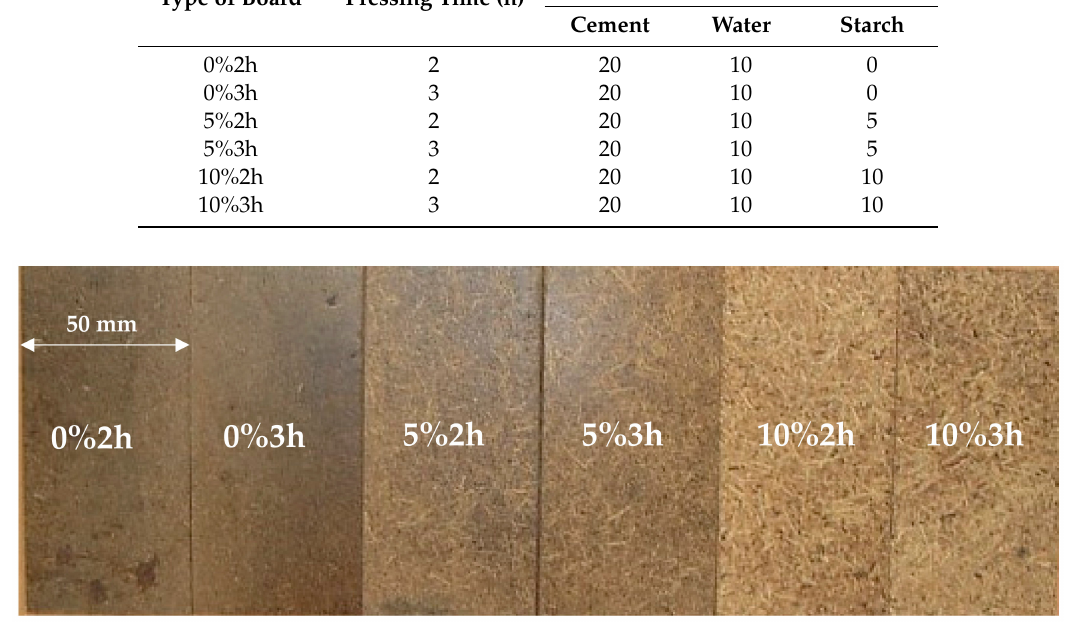
Figure 2. Types of boards